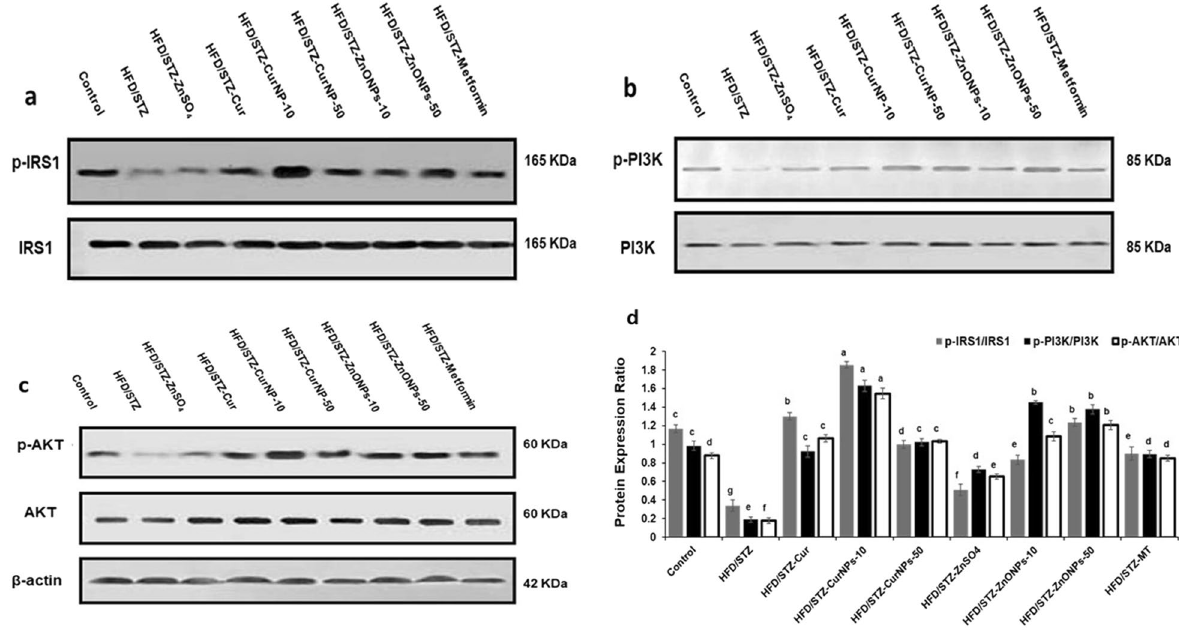
Figure 7. Insulin signaling pathway expression levels by western blot. ( a ) Liver anti-IRS1 & anti-IRS1 pTyr612. ( b ) anti-PI3K & anti-PI3K p85. ( c ) anti-AKT1 & anti-AKT1 pser473 protein levels were measured by western blot. ( d ) Quantitative analysis of p-IRS1/IRS1, p-AKT1/AKT1, and p-PI3K/PI3K in liver tissue of HFD/STZ- induced rats and after treatment with CurNPs and ZnONPs. Values are mean ± SEM (n = 3), means for the same parameter with different letters in each bar are significantly different (Tukey, p < 0.01).